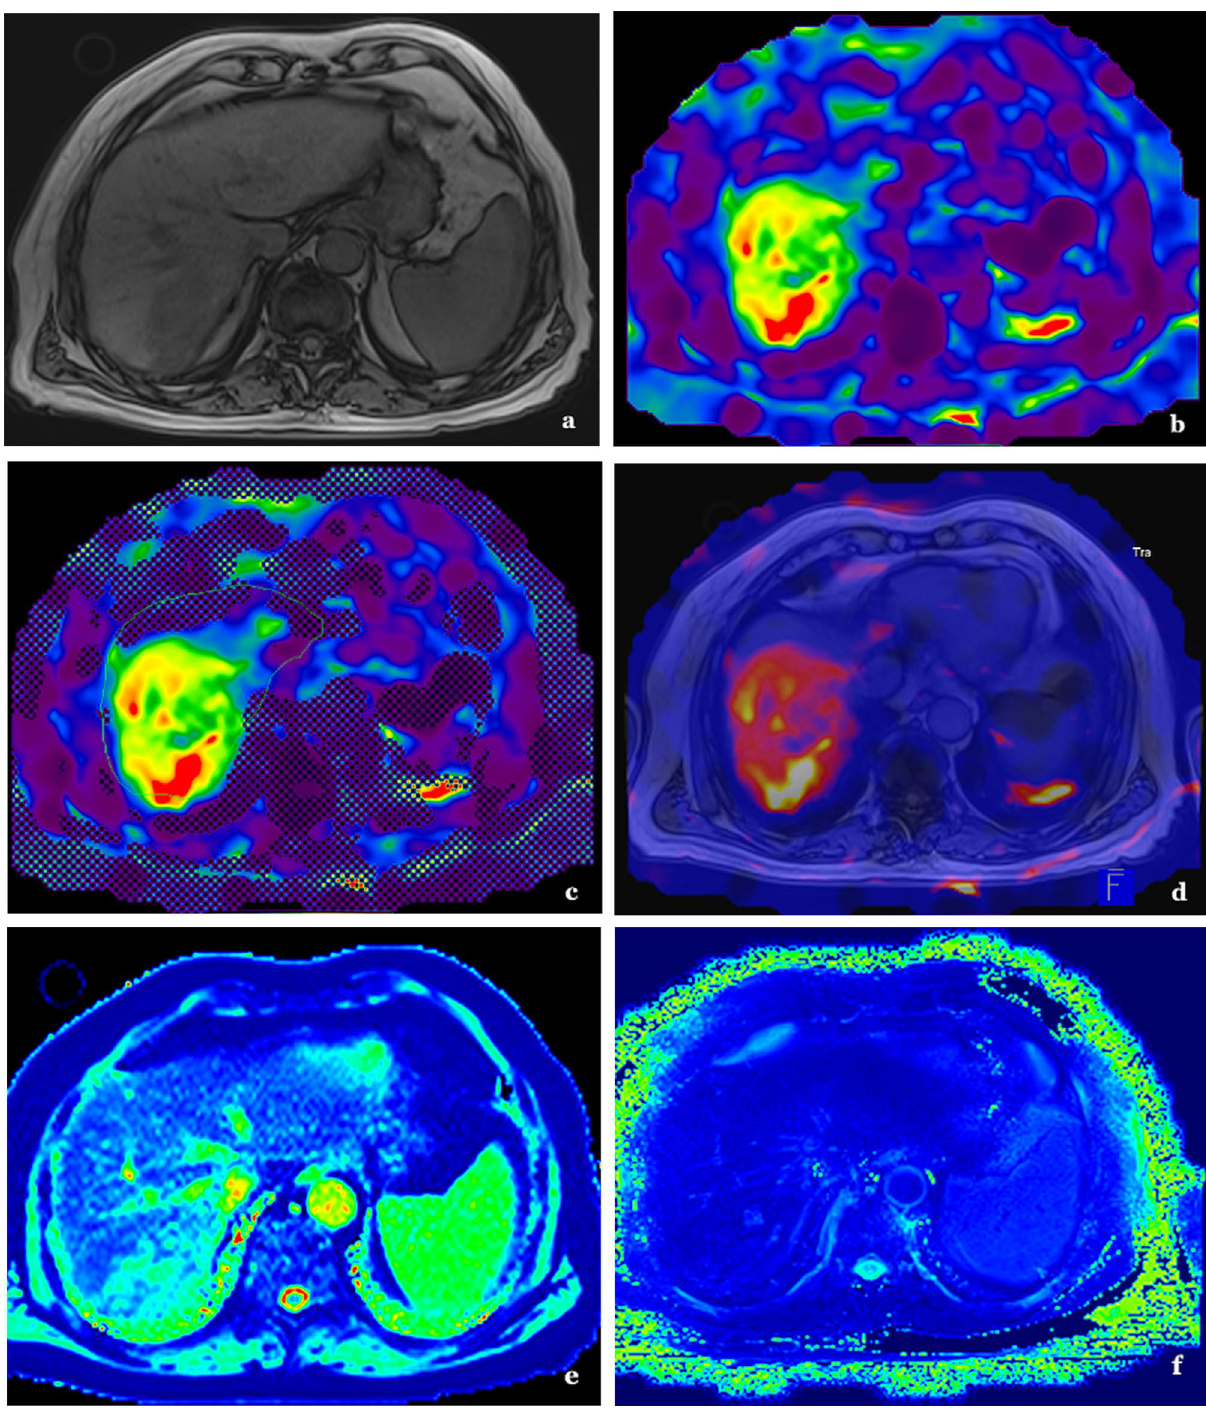
Figure 2. MRI and MRE images. 64 years old male patient with HCC in the RLL with unenhanced T1-imaging ( a ), MRE without ( b ) and with ( c ) liver detection system, 3D-fusion of MRI and MRE ( d ) and MAP T1 ( e ) and MAP T2 ( f )